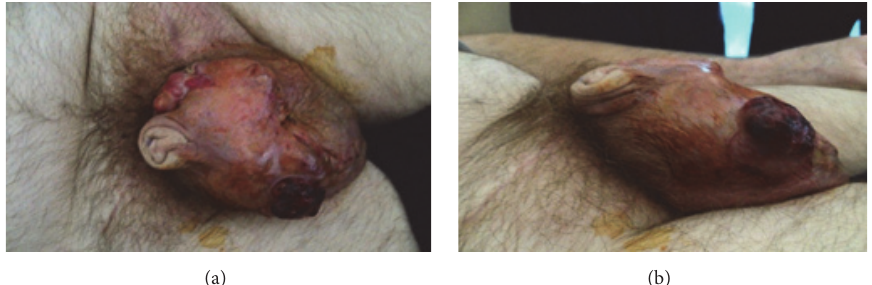
Figure 1: Lateral and anterior views of pretreatment scrotal involvement by nonseminomatous germ cell tumour.